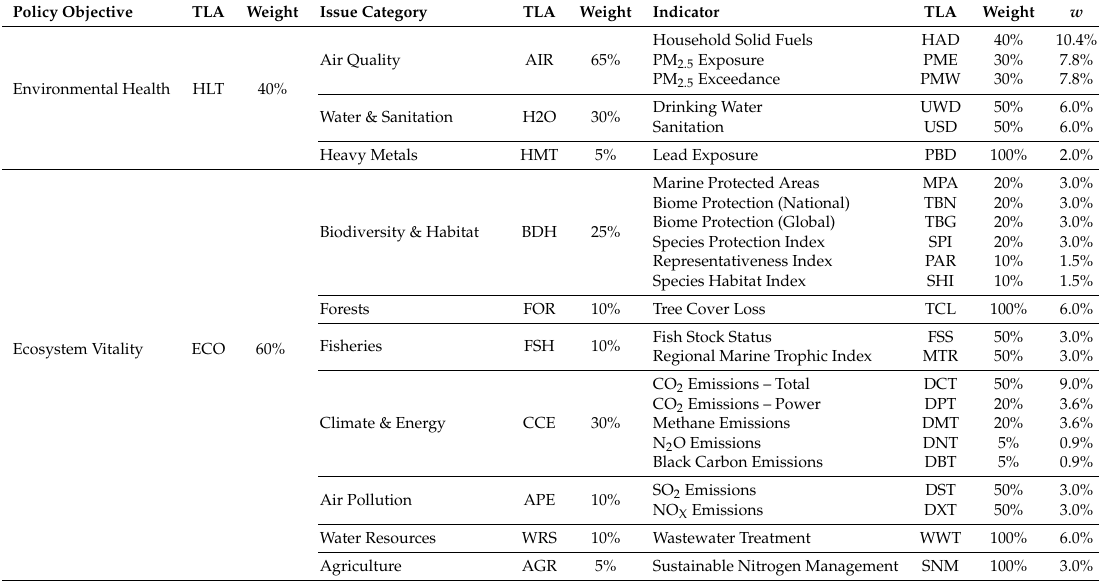
Table 1. Policy objectives, issue categories, indicators, and weights from the Environmental Performance